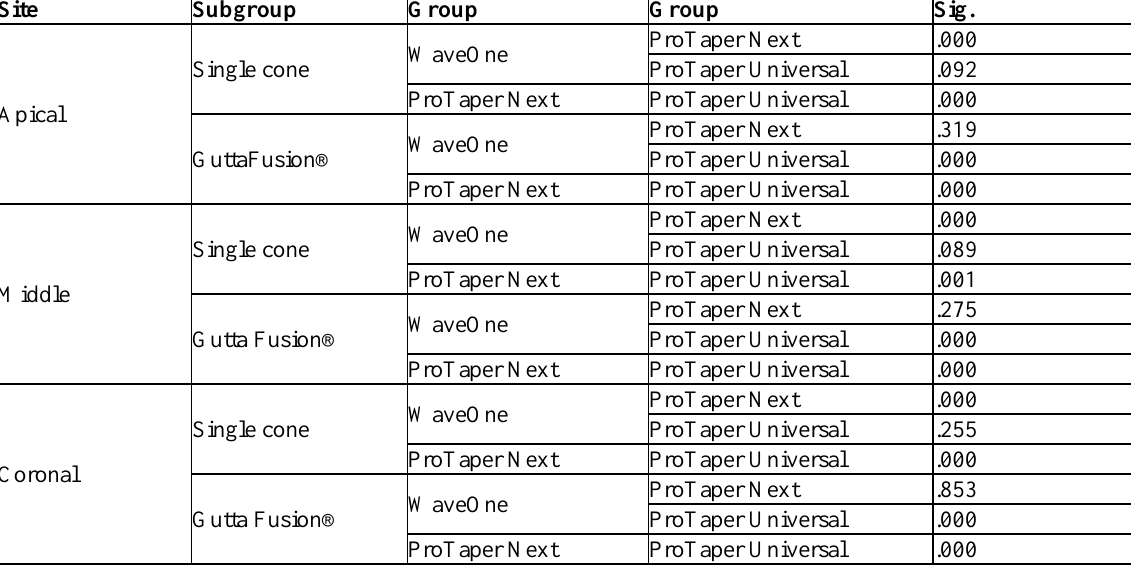
Coronal Df=1. Table 3: LSD tests for push out bond strength among groups by subgroups at three sites Site Subgroup Group Group Sig. ProTaper Next .000 WaveOne Single cone Apical